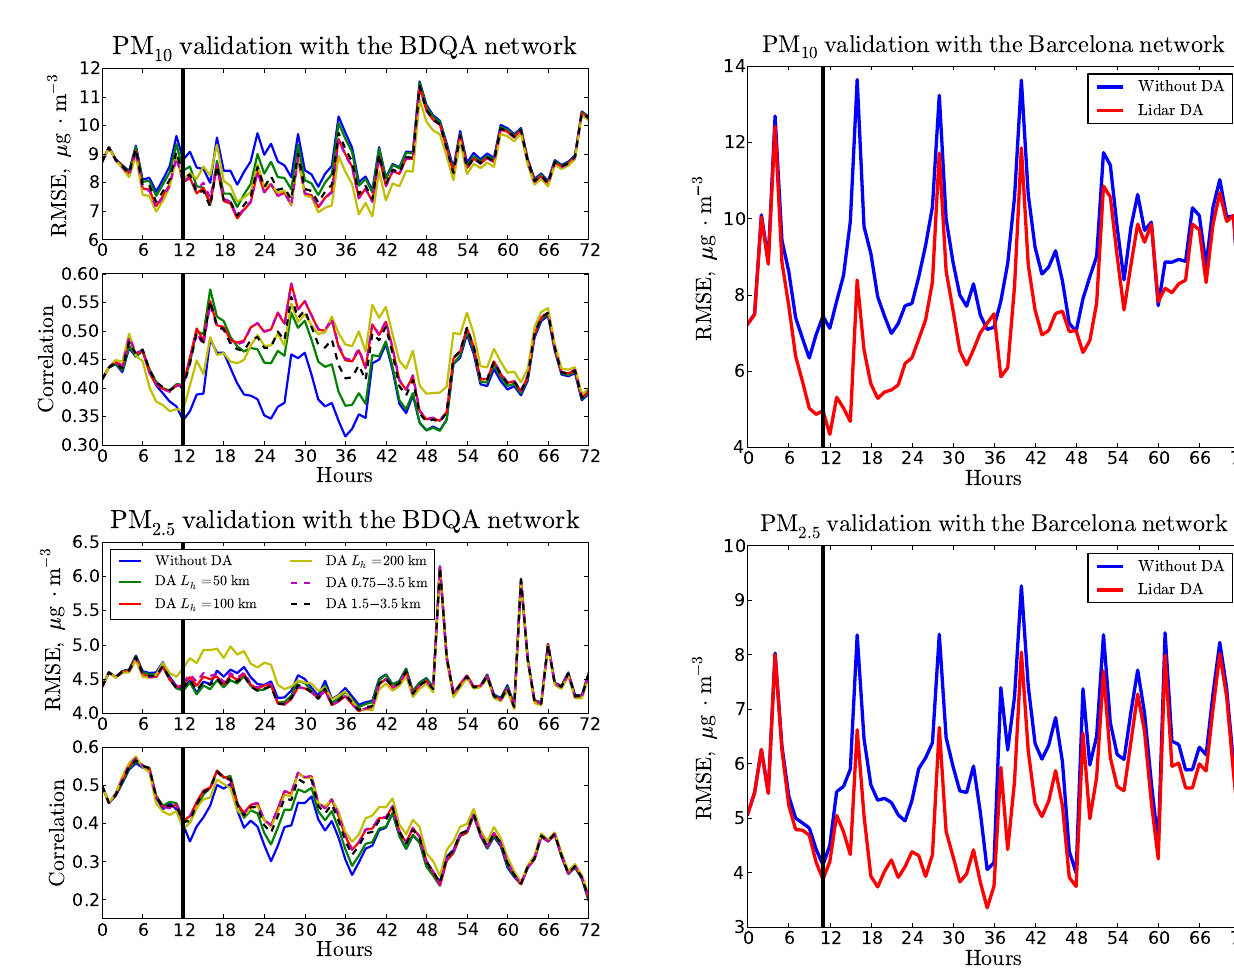
Figure 11. The top (or bottom) panel shows the time evolution of the RMSE (µgm − 3 ) of PM 10 (or PM 2 . 5 ) averaged over the differ- ent experiments without and with DA ( L h = 100km and altitude range 1.0–3.5km). For the six successive experiments, the time ori- gin corresponds respectively to 06:00UTC on 9 July, 18:00UTC on 9 July, 06:00UTC on 10 July, 18:00UTC on 10 July, 06:00UTC on 11 July and 18:00UTC on 11 July. The scores are computed for three stations around Barcelona (hourly data, see Fig. 1). The verti- cal black lines denote the separation between the 12h assimilation period (to the left of the black lines) and the 60h forecast period (to the right of the black